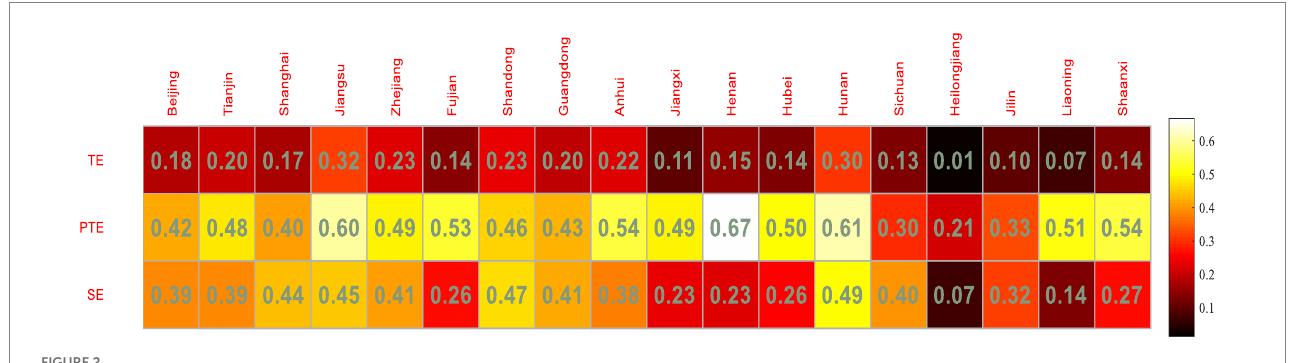
FIGURE 2 Strategic emerging industries technology and finance stage 1 DEA Evaluation